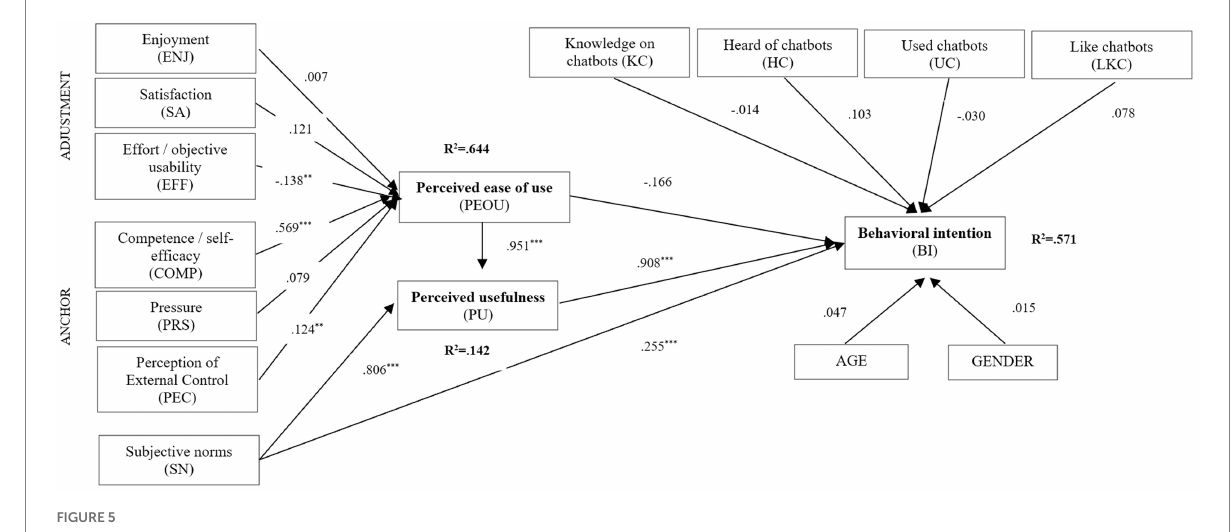
FIGURE 5 Results of the structural